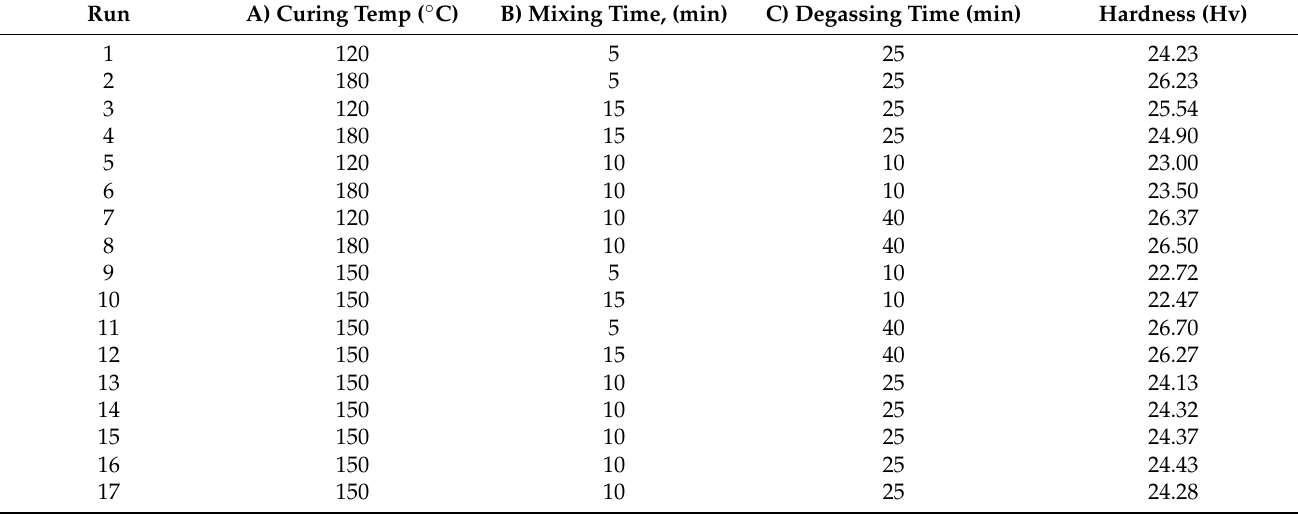
Table 5. Experimental results of hardness strength